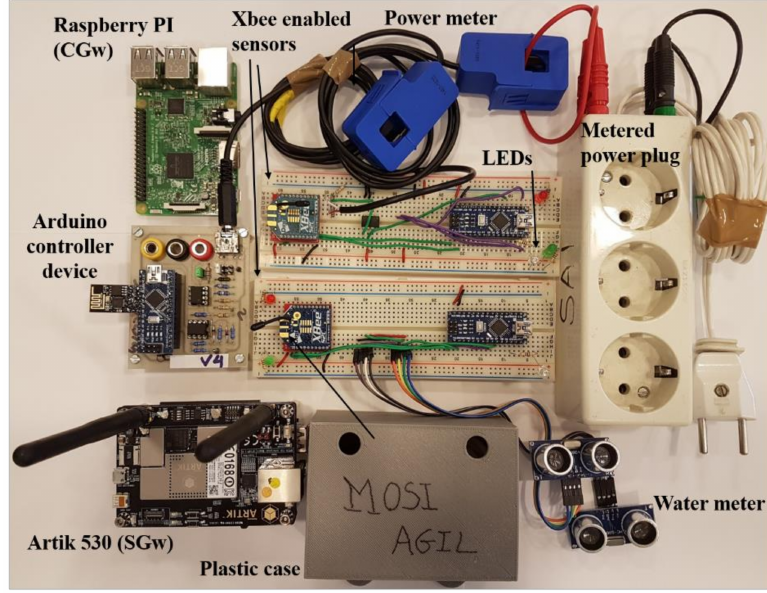
Figure 7. Implementation